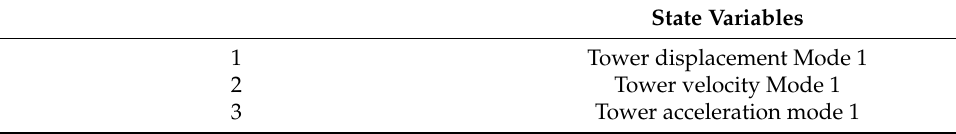
Table A1. Partial state